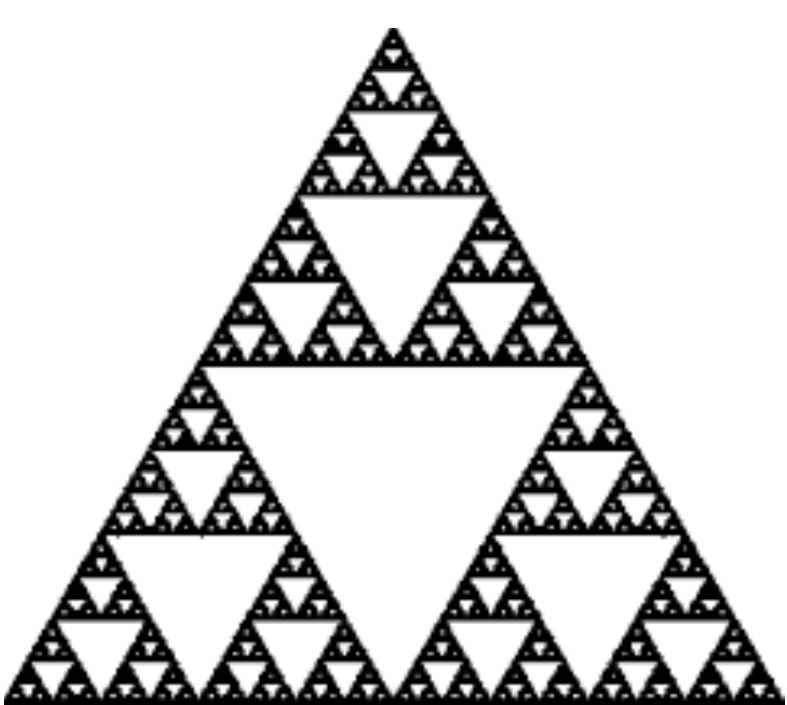
Figure 1. The Sierpinski